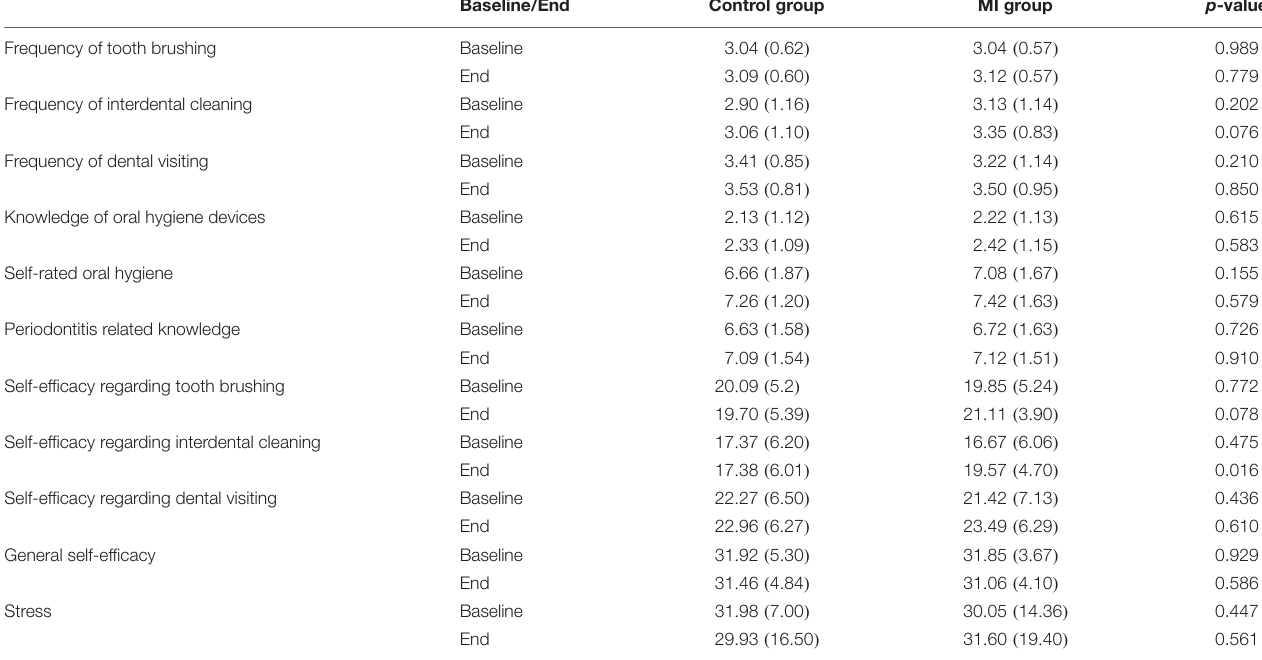
TABLE 2 | Results regarding oral hygiene, self-efficacy and stress.